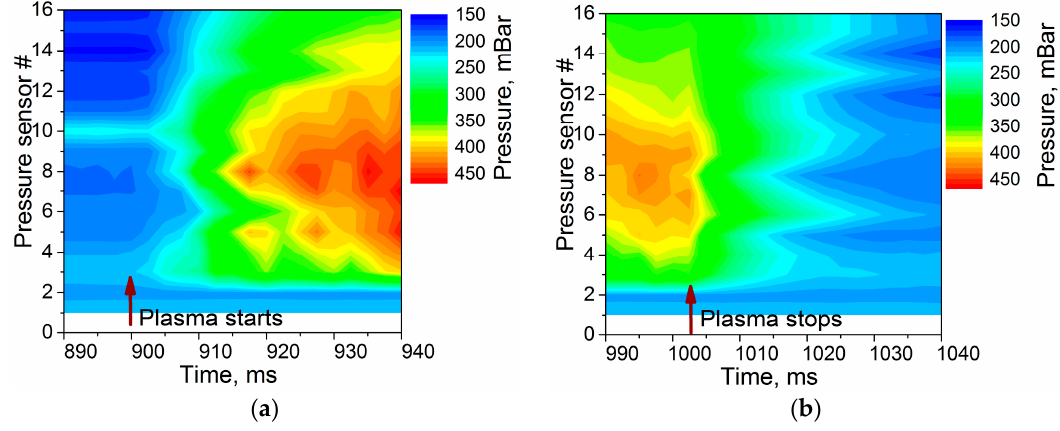
Figure 26. 2D dynamics of pressure distribution over upper wall at ( a ) ignition and ( b ) flame extinction.